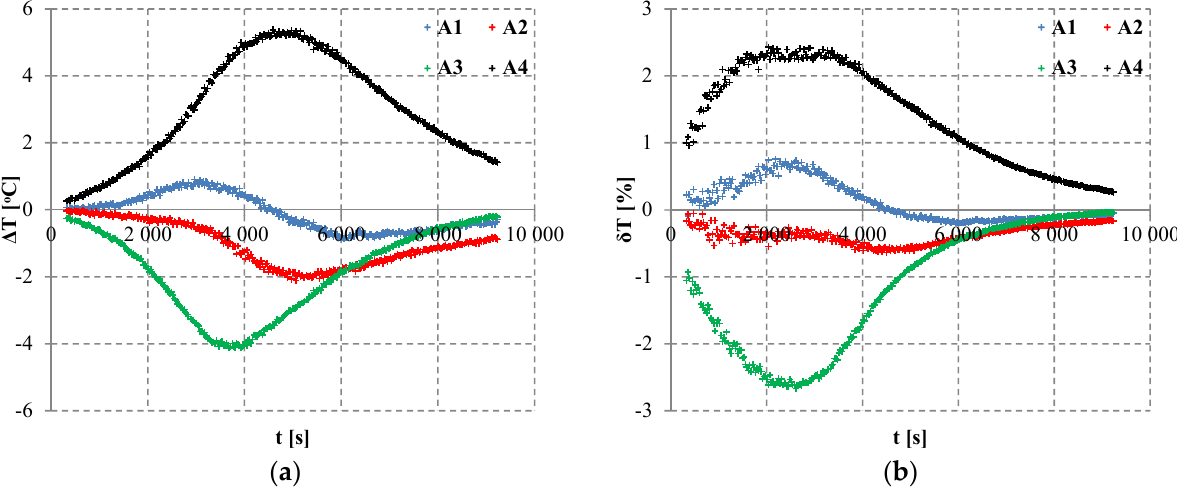
Figure 8. Course of the absolute difference ( a ) and of the relative difference ( b ) for temperature and process p5 in planes A1, A2, A3 and A4.